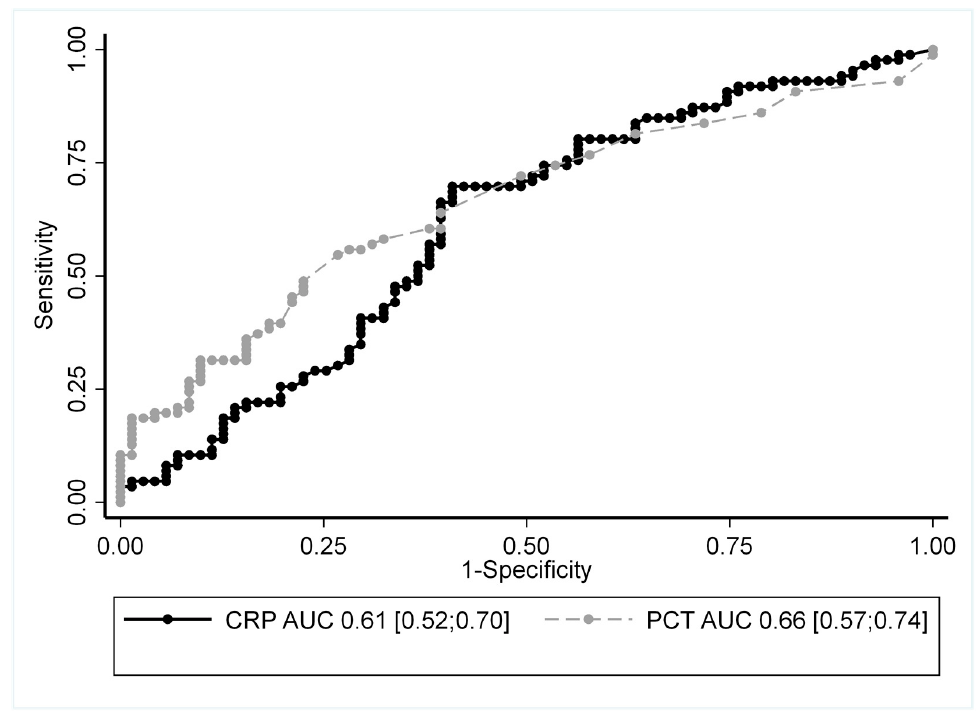
Figure 2. The receiver operating characteristic (ROC) curve of PCT and CRP to differentiate infection from vasculitis flare. AUC: area under the curve and its 95% confidence interval.